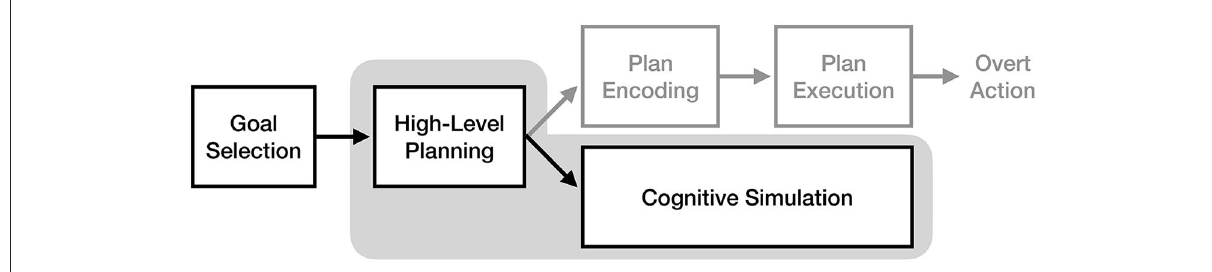
FIGURE4 The process of motor imagery as proposed by the motor-cognitive model. The stages of motor execution thought to be responsible for the experience of motor imagery are enclosed in gray.